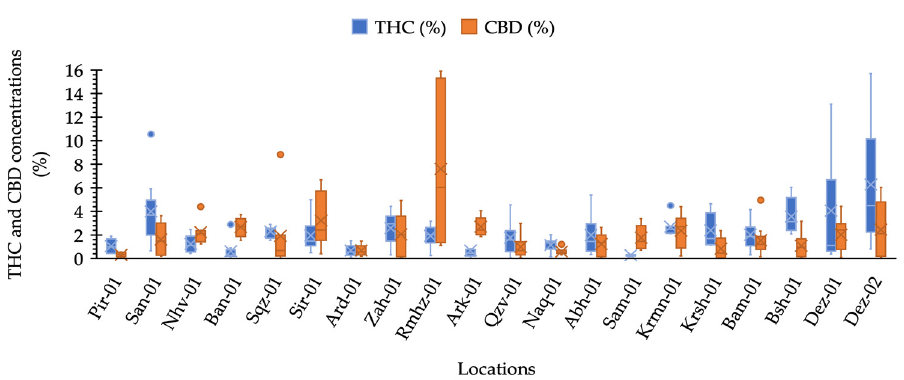
Figure 2. Box plot analysis of CBD and ∆ -9-THC concentration (%) distribution measured for pistillate cannabis plants in each location.